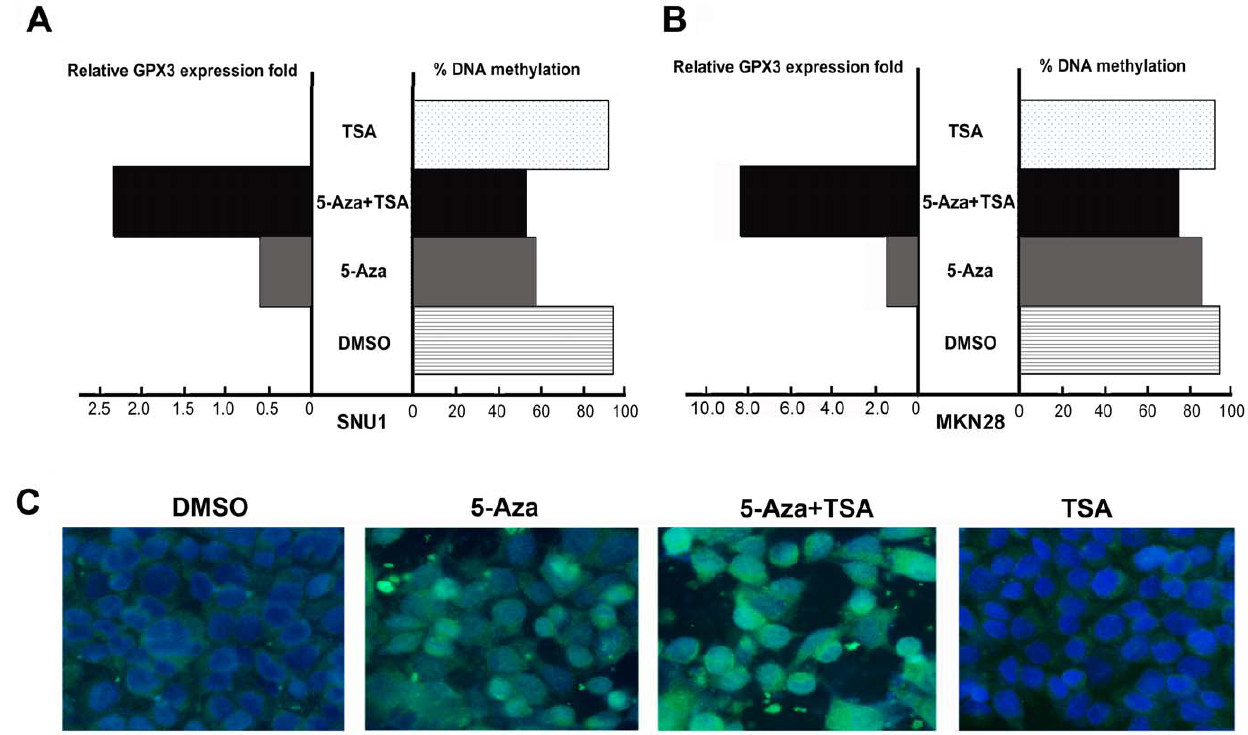
Figure 4. 5-Aza treatment restored GPX3 gene expression in gastric cancer cell lines with silenced GPX3. SNU1 and MKN28 cancer cells were treated with 5-Aza and TSA as described in the Methods section. In A (SNU1 cells) and B (MKN28 cells), relative GPX3 expression ratios normalized to HPRT are shown in the left panel. DNA methylation levels of corresponding samples are shown on the right panel. C shows immunofluorescence staining of GPX3 protein in SNU1 cells. 5-Aza, 5-Aza-2 9 deoxycytidine. TSA, Trichostatin-A.